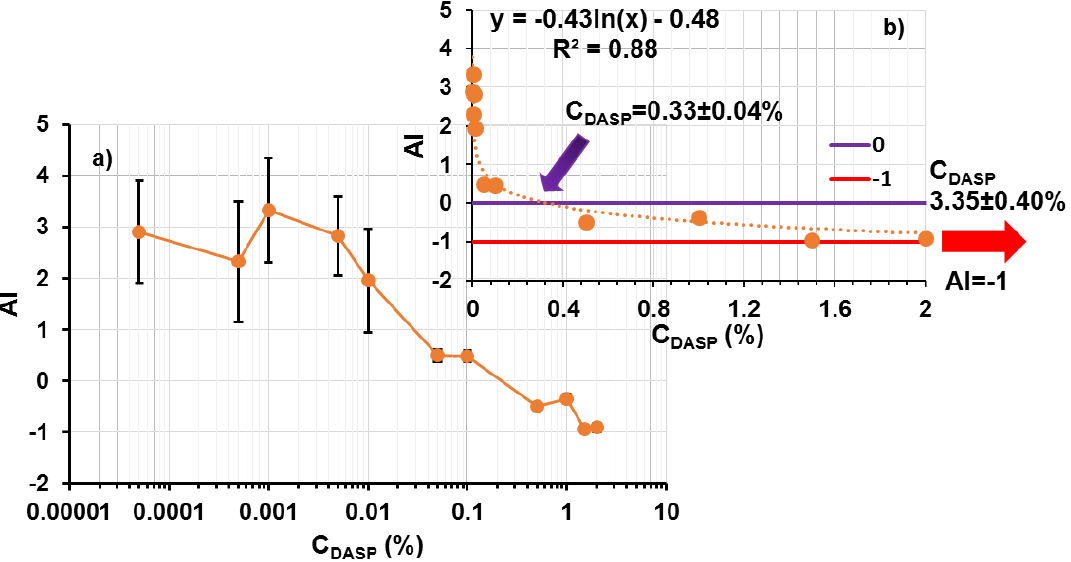
Figure 3. ( a ) The dependence of the aggregation index (AI) on the DASP fraction concentration (C DASP ) and ( b ) the determination of the pectin concentration corresponding to AI = 0 and AI = − 1; the bars indicate standard deviation.